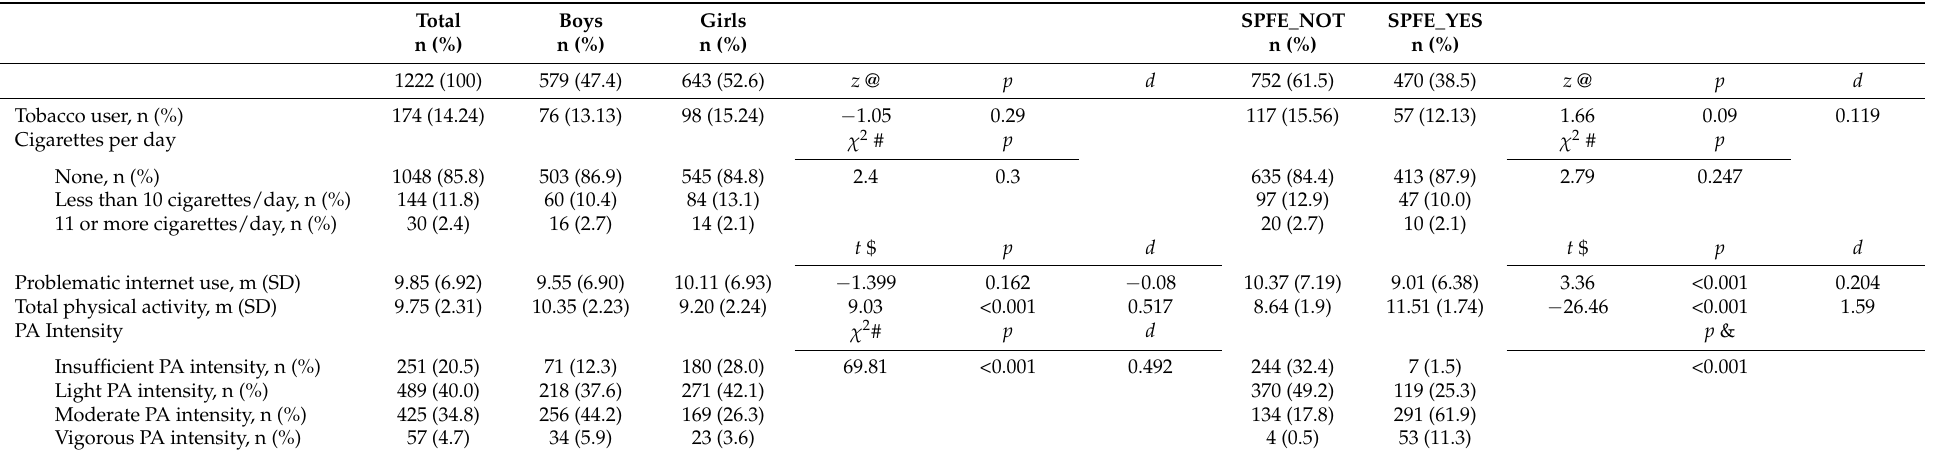
Table 1. Descriptive characteristics of the